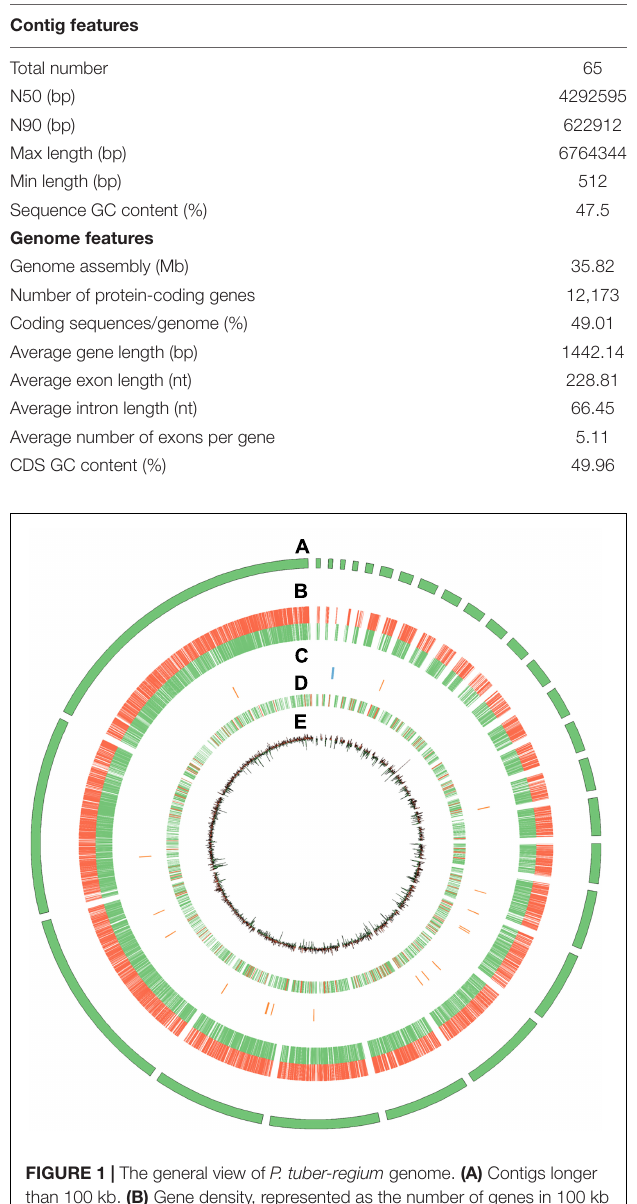
TABLE 1 | Genome statistics of P. tuber-regium .